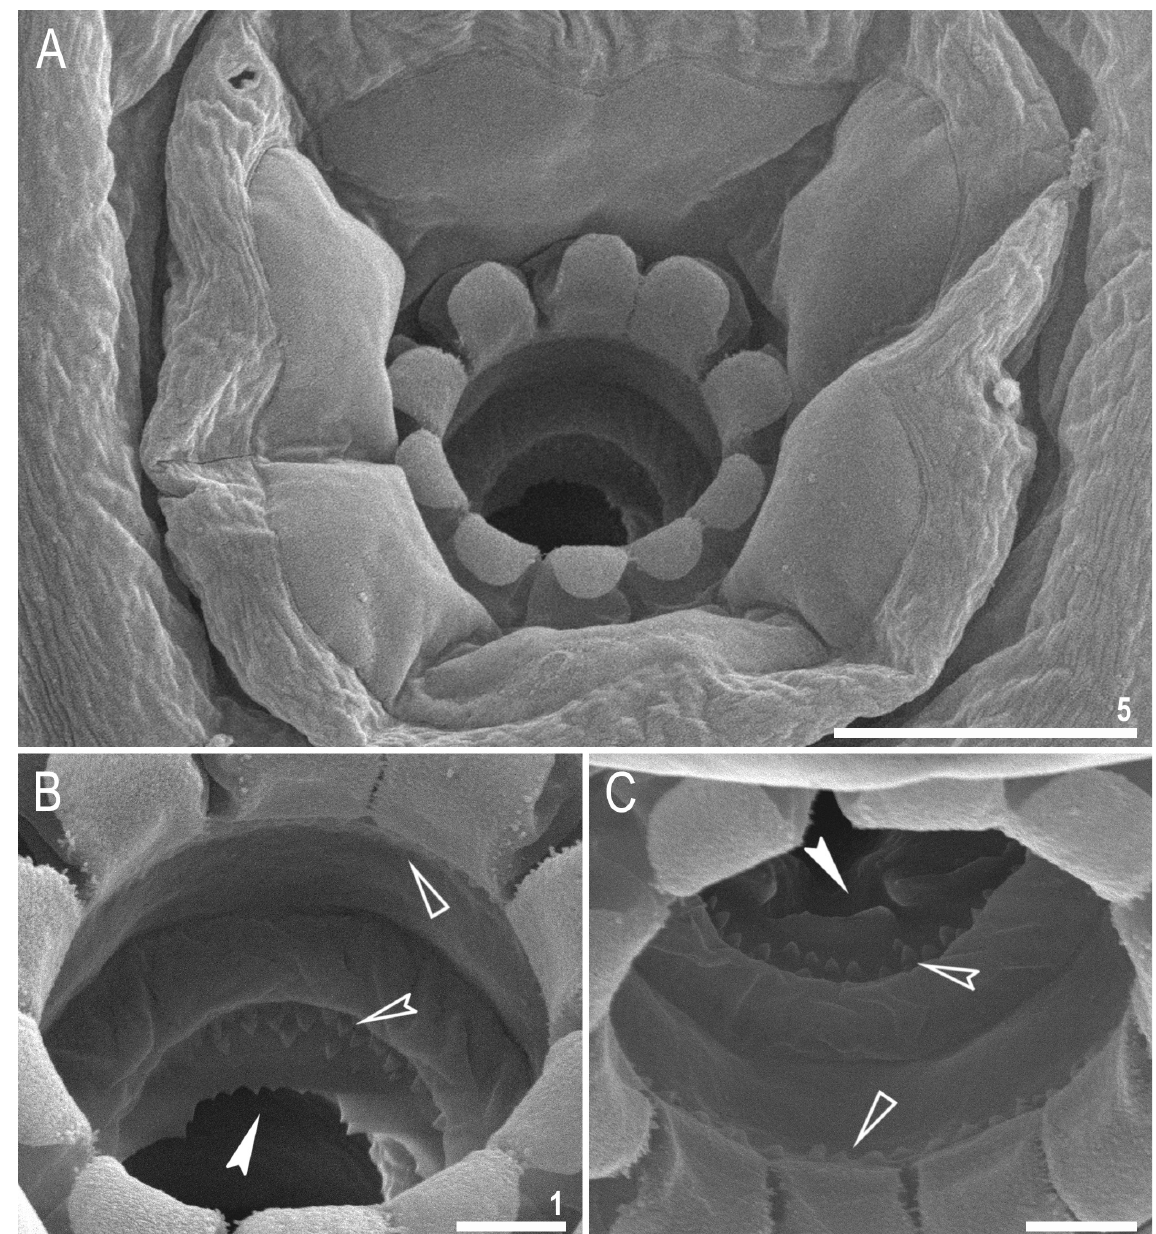
Fig. 13. Macrobiotus kamilae sp. nov., mouth opening and the oral cavity armature seen in SEM (paratype, IZiBB). A . Mouth opening with peribuccal sensory lobes and ten peribuccal lamellae. B–C . The oral cavity armature of a single paratype seen in SEM from different angles, in dorsal (B) and ventral (C) views, respectively. Empty flat arrowheads indicate the first band of teeth in the oral cavity, empty indented arrowheads indicate the second band of teeth in the oral cavity and filled indented arrowheads indicate the third band of teeth in the oral cavity. Scale bars in